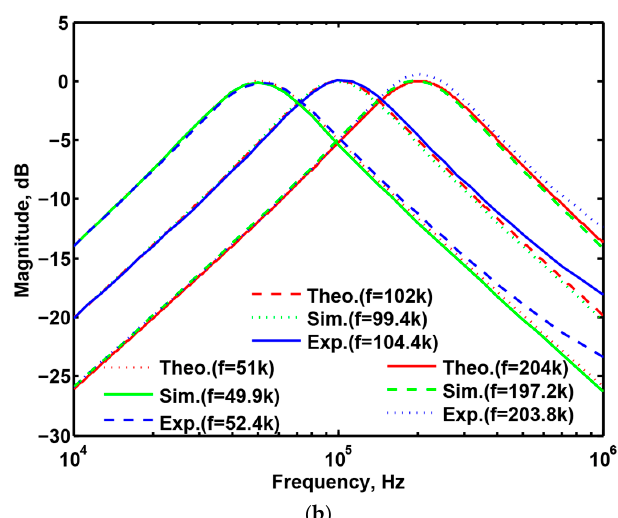
Figure 8. Theoretical, simulated, and experimental gain response of the band-pass filter responses. ( a ) Variation in Q while keeping f o ; and ( b ) variation in f o while keeping Q.